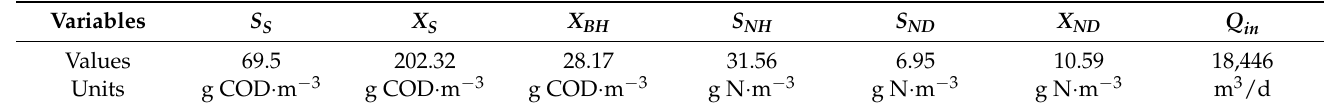
Table 1. Constant influent data.